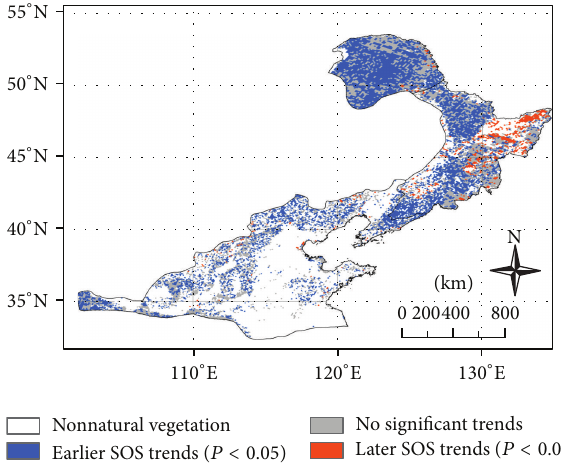
Figure 8: Location of trends in SOS (1982–2006) calculated using the Midpoint method. The pixels with earlier SOS trends ( 𝑃 < 0.05 ), no significant trends ( 𝑃 > 0.05 ), and later SOS trends ( 𝑃 < 0.05 ) occupy 50.7%, 44.0%, and 5.3% of the total natural vegetation area, respectively.